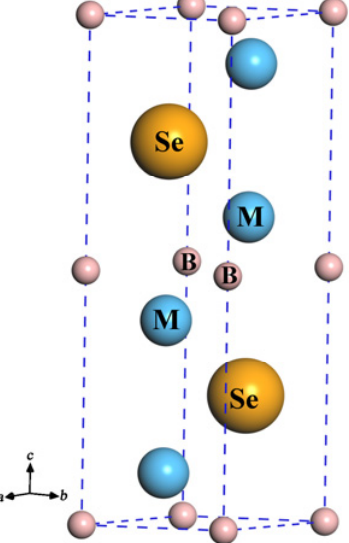
Fig. 1 Crystal structure of M 2 SeB (M = Zr, Hf), where M, Se, and B atoms are located at 4f (1/3, 2/3, z ), 2c (1/3, 2/3, 1/4), and 2a (0, 0, 0) positions, respectively. Table 1 Lattice constants, atomic positions, and M–B and M–A bond lengths in M 2 AB (M = Nb, Zr, Hf; A = S,